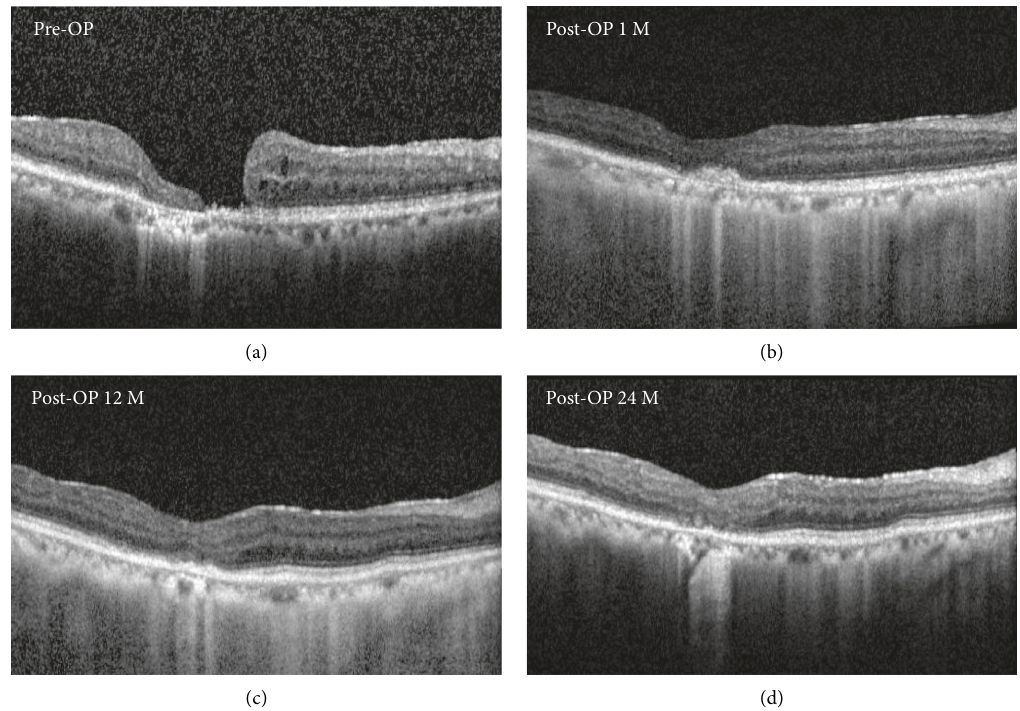
Figure 2: OCT findings after autologous retinal transplantation (ART) of case 1. (a) OCTscan obtained before surgery showing a macular hole with a diameter of 811 μ m. The BCVA was 20/200. (b) OCTobtained at postoperative 4 weeks after ARTshowing early integration of the flap and some glial tissue seen in the outer retina. The BCVA was 20/150. (c) OCTscan obtained at postoperative 12 months showing further reconstitution of the ELM and EZ bands and a decrease of glial tissue. The BCVA was 20/100. (d) OCT scan obtained at postoperative 24 months showing properly positioned in situ of the flap. The BCVA was maintained at